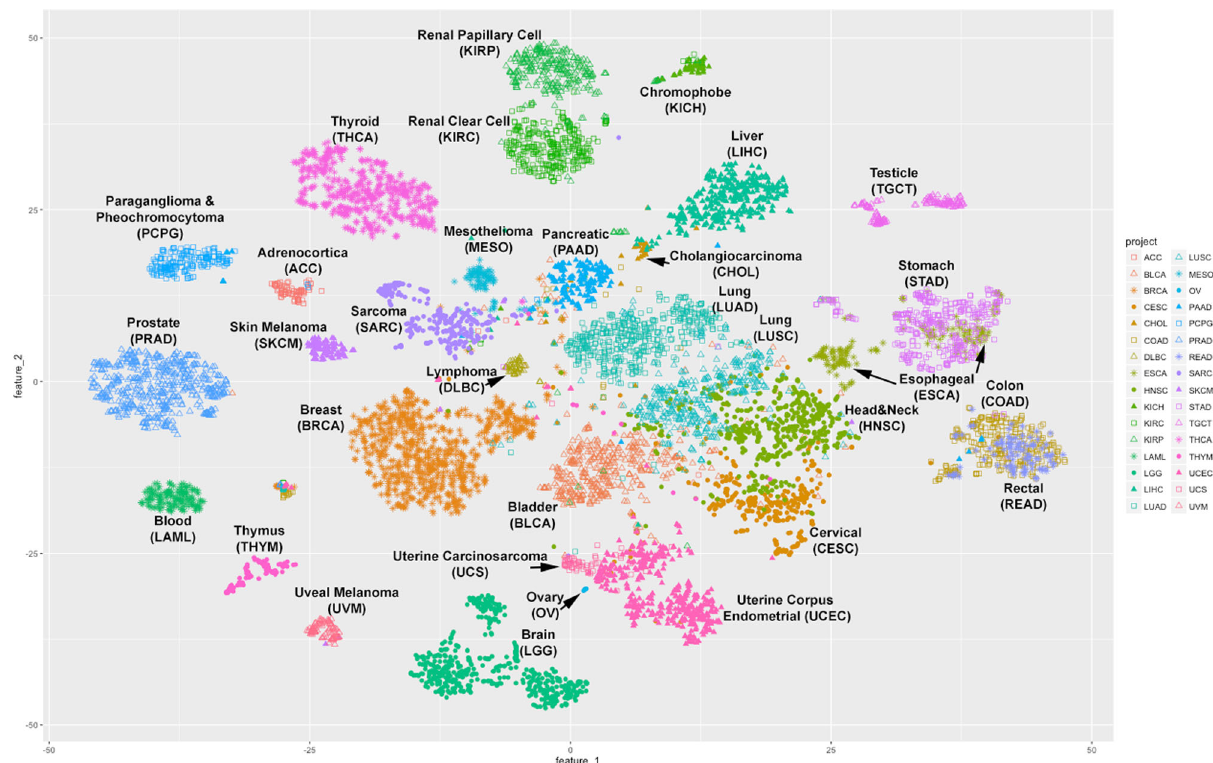
Fig. 6 2D t-SNE clustering of 32 TCGA projects. Combined genomic and epigenomic signals of 4 data types from each TCGA patient, including somatic gene-level copy number, somatic RNA expression, somatic miRNA expression and somatic DNA CpG methylation patterns, are aggregated and superimposed into a 2-dimensional space using t-SNE algorithm. Each dot in the plot represents one patient, and patients from different TCGA projects (and cancer types) are distinguished color and shape of the